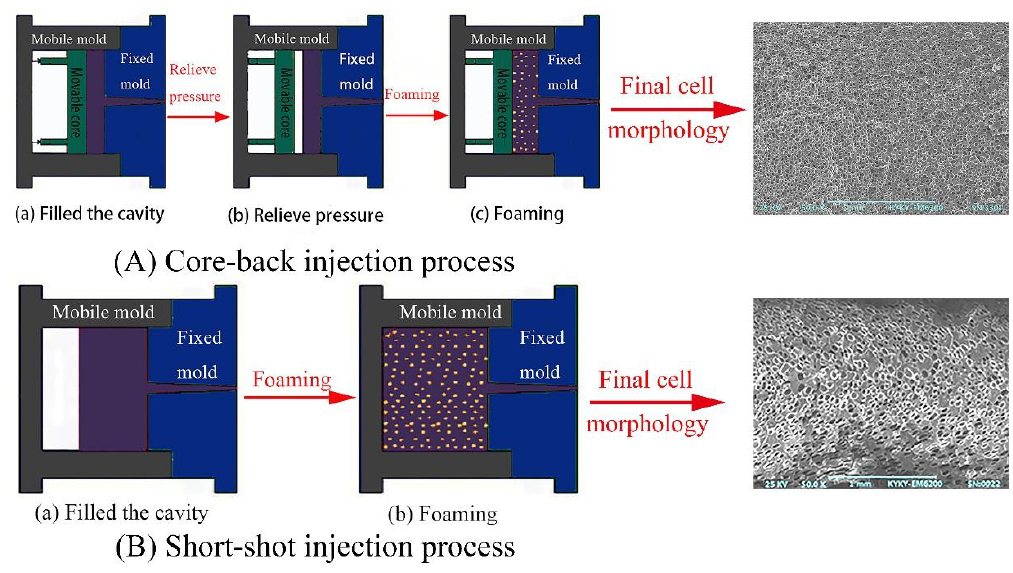
Figure 11. Schematic of the foam material process forming of ( A ) the core-back injection process and ( B ) the short-shot injection process.